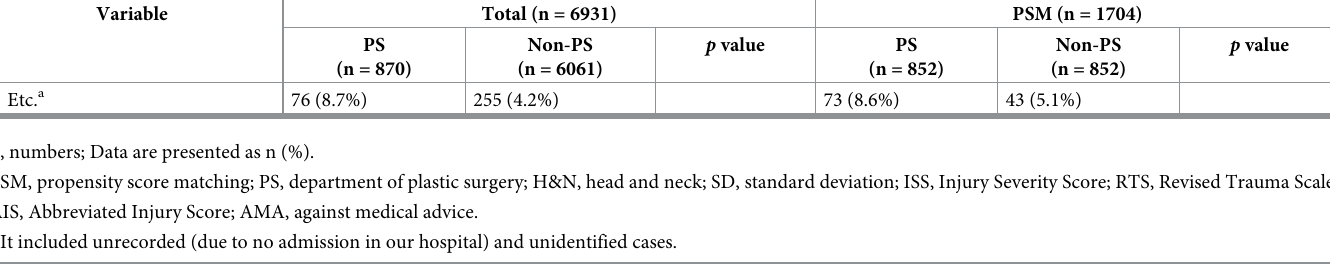
While patients in the H&N category ranged from 1 to 6 in AIS scores, those in the face cate- gory had AIS scores of no more than five. The significance was not reviewed because there were duplicate patients in both groups. Instead, we identified only the tendency between the two AIS categories and the treatment outcomes. Within the same AIS scores, patients in the face category showed poor overall outcomes (RTS, total and ICU LOS). This tendency was par- ticularly marked in patients with an AIS score of 3. Compared to H&N patients, face category patients had approximately 2–4 times longer total and ICU LOS (20.55 ± 24.68 days vs.